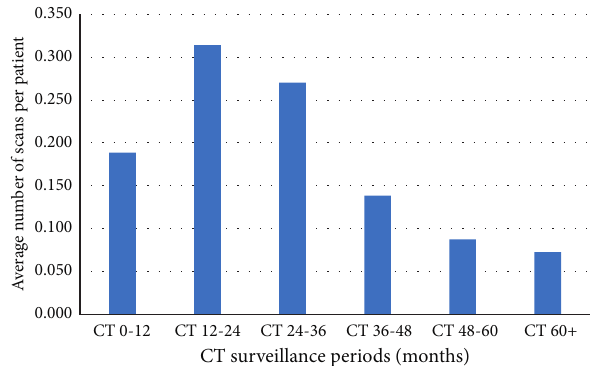
Figure 2: Histogram demonstrating the distribution of computed tomography (CT) follow-up averaged per patient. The average imaging follow-up of patients undergoing CT imaging follow-up was 47.6 months.